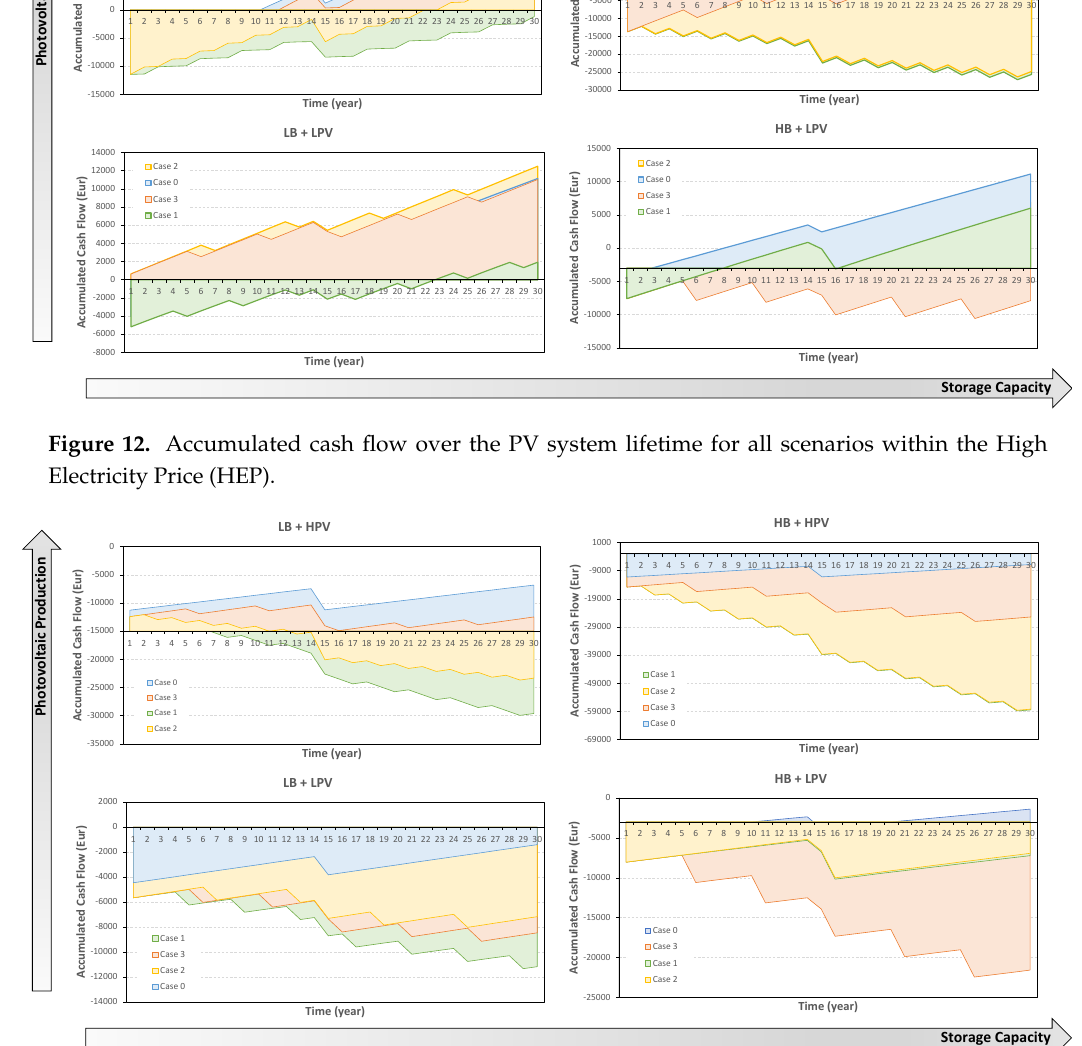
Figure 13. Accumulated cash flow over the PV system lifetime for all scenarios within the Low Electricity Price (LEP).